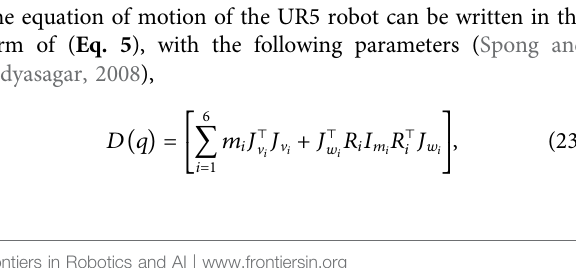
Frontiers in Robotics and AI |